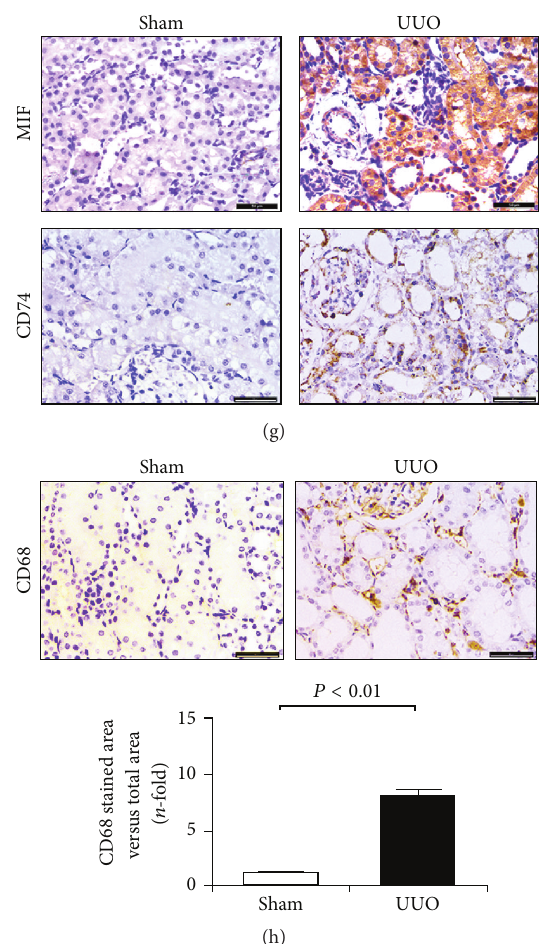
Figure 1: Obstruction-induced matrix deposition and MIF expression in kidneys. (a) PAS and Masson’s trichrome staining of renal cortex sections revealed marked tubular dilation and atrophy associated with excessive matrix deposition and inflammatory cells infiltration. Bar: 50 𝜇 m. (b) Protein expression of type III collagen determined by immunohistochemical staining was upregulated in UUO kidneys compared with the sham. Bar: 100 𝜇 m. (c) qRT-PCR analysis indicated increased mRNA expressions of Col1 𝛼 1 and Col3 𝛼 1 in UUO kidneys. (d) ELISA assay showed enhanced TGF- 𝛽 1 levels in UUO kidneys. (e) Western blot analysis showed increased MIF expression in UUO kidneys. (f) qRT-PCR revealed elevated mRNA expression of MIF in UUO kidneys. (g) Immunohistochemical staining identified upregulated expression of MIF and CD74 in UUO kidneys. Bar: 50 𝜇 m. (h) Enhanced CD68 expression reveals marked macrophage infiltration in UUO kidneys. Bar: 50 𝜇